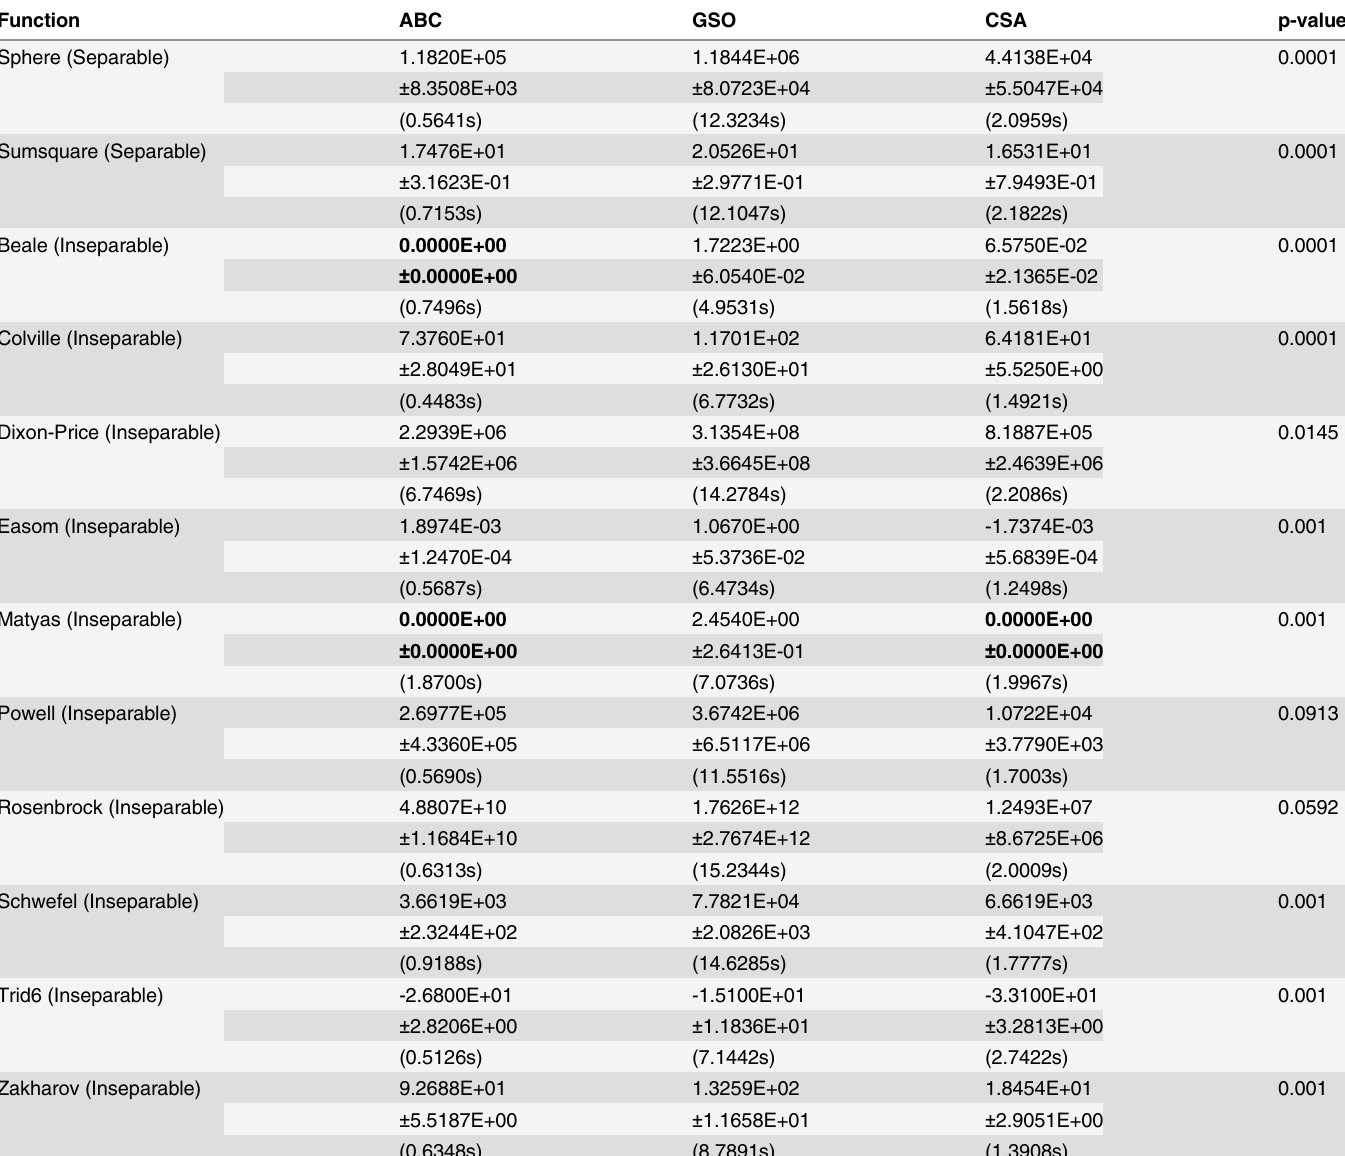
Table 4. Benchmark Functions Comparison of mean error (Mean ± SD) and time (Seconds) on Several Optimization